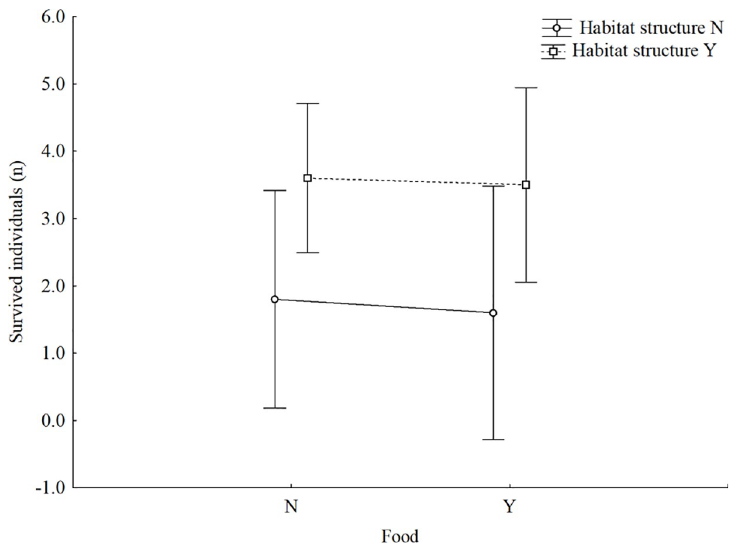
Fig 4. Interaction of habitat structure and food supply on the number of survived Sympetrum individuals. The model tested the influence the interaction of food supply and habitat structure on the interspecific predation between the sprawlers C . erythrea and Sympetrum spp.; Y = presence of artificial plant or alternative food, N = absence of artificial plant or alternative food. The bars represent the 95% confidence intervals.